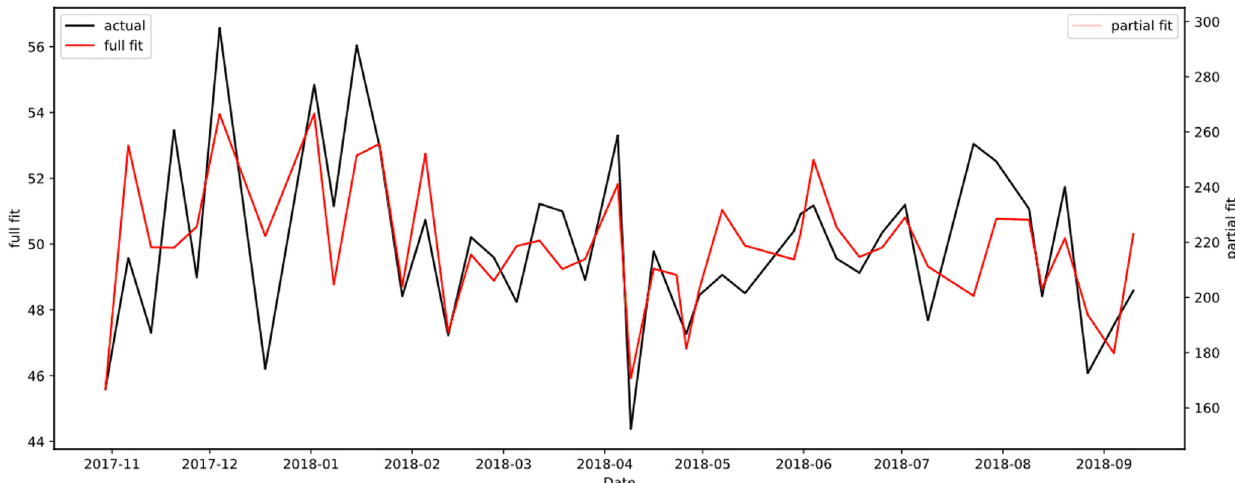
Figure 2. Model of total signal-to-noise ratio using scanning parameters from phantom data. R 2 value was 0.533, indicating scanning parameters have explanatory